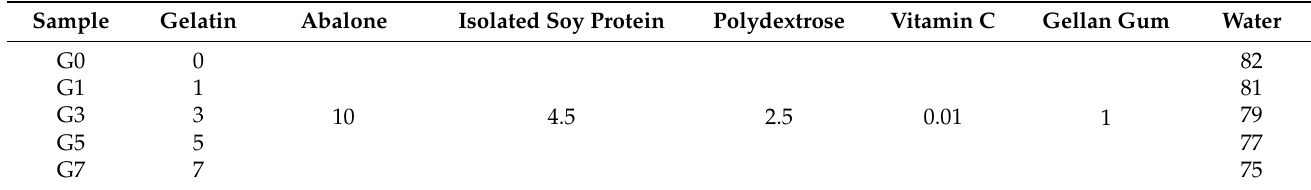
Table 1. Nutritional compositions (g) per 100 g of the abalone 3D print inks (APIs). Sample Abalone Isolated Soy Protein Polydextrose Vitamin C Gellan Gum